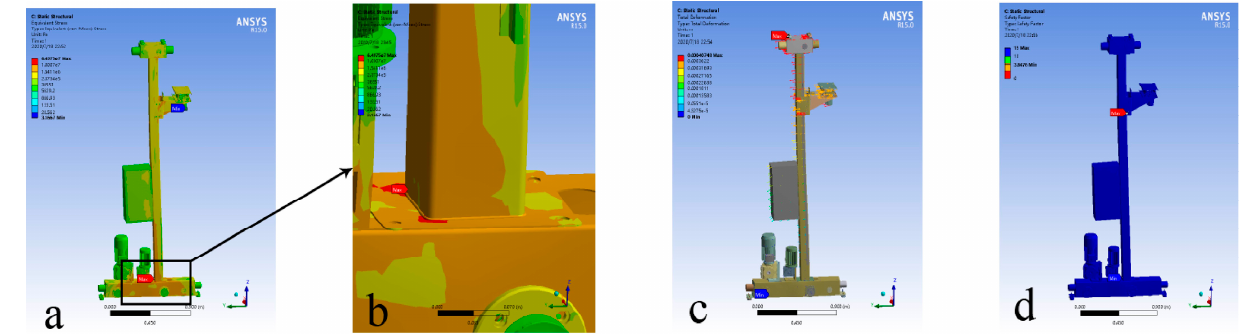
Figure 6. ( a ). Equivalent stress cloud map of the model under static state; ( b ) drawing of partial enlargement; ( c ) phase change cloud map; ( d ) stress safety factor cloud map.